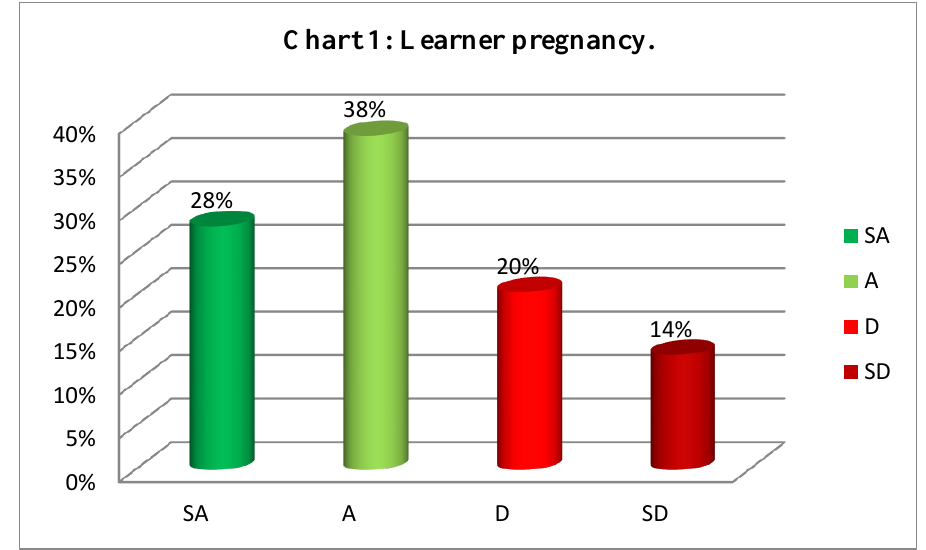
Figure 3. Learner Pregnancy Chart 1: Learner